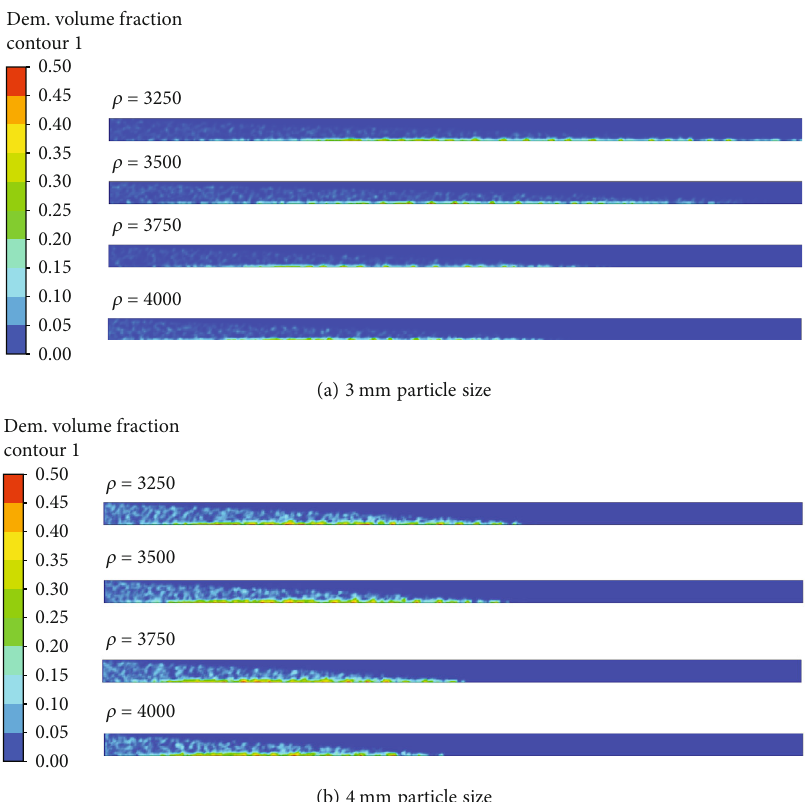
Figure 6: Cloud map of solid phase particle volume fraction for 3 mm and 4mm particle size